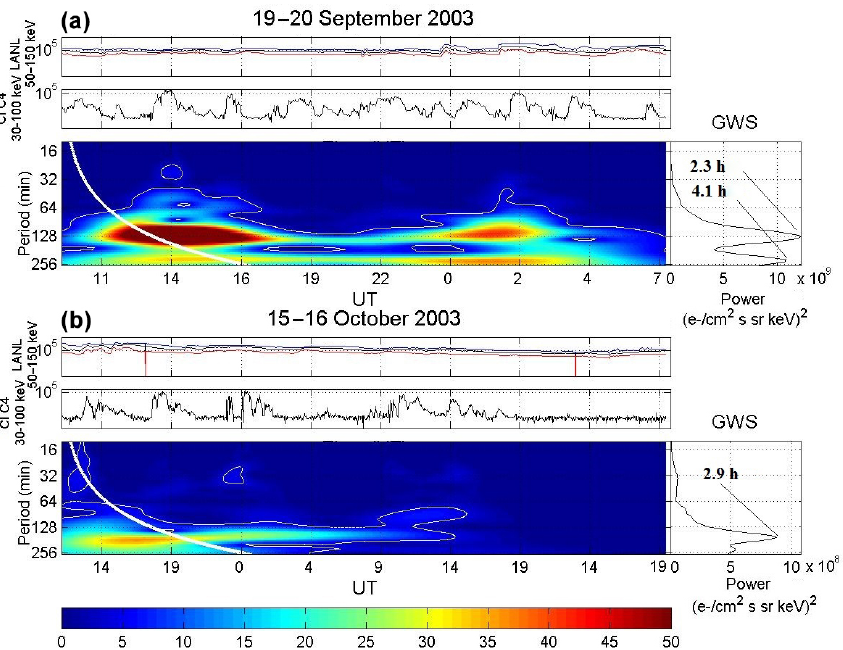
Figure 8. Cross-wavelet spectra between Cluster RAPID>100keV electron data and three LANL electron channels for the (a) 19– 20 September 2003 tail crossing (T2) and for the (b) 15–16 October 2003 tail crossing (T5). Otherwise the format is the same as for Fig. 4.